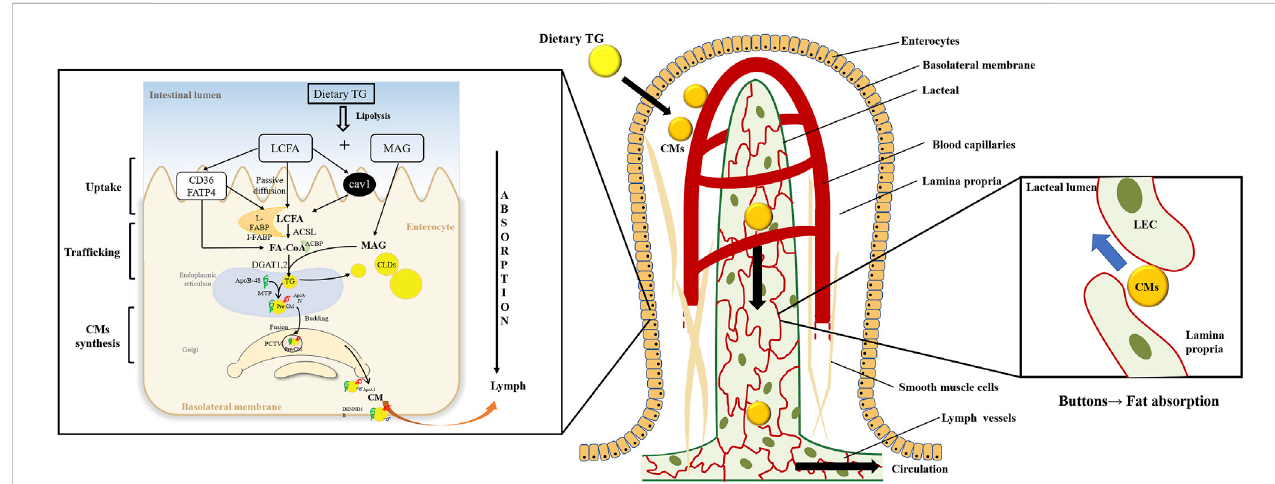
FIGURE 1 Dietary triglyceride transport from the intestinal lumen, enterocytes, and lacteals. Dietary triglyceride (TG) is hydrolyzed into long-chain fatty acids (LCFAs)andmonoacylglycerols(MAGs)intheintestinallumen.Theenterocytesuptakethedigestionproductsandtraf fi cthemintotheendoplasmicreticulum (ER). And TG is resynthesized in the ER, which may bud off the ER membrane to form cytoplasmic lipid droplets (CLDs) or be assembled to form pre- chylomicrons (pre-CMs). The pre-CMs are transported to Golgi in pre-chylomicron transport vesicle (PCTV) for further mature. Then mature chylomicrons (CMs) exit the basolateral membrane to lamina propria. CMs are transported into the lacteals through the buttons junction of lymphatic endothelial cells (LECs) and secreted into the lymphatic vessels before entering circulations.